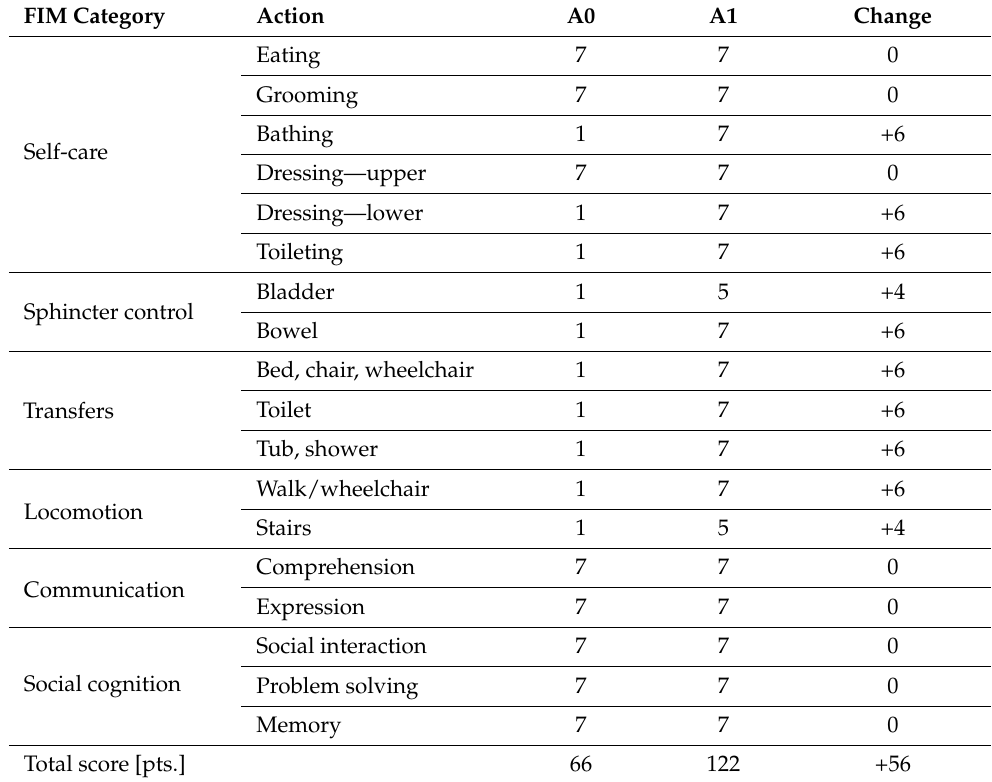
Table 2. Functional status assessment using the FIM scale before and after